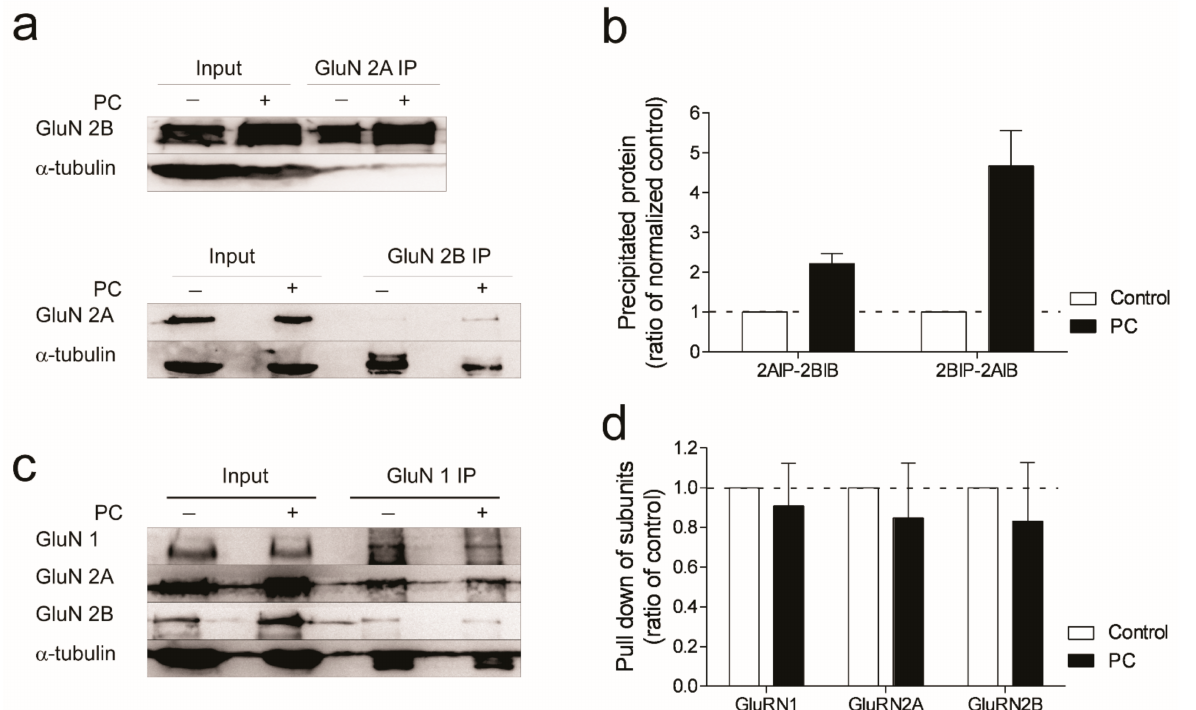
Figure 4. Increase of tri-heteromeric NMDA receptors following ischemic preconditioning. Cultured neurons of 12–13 DIV were treated with either sham OGD or 30 min OGD followed by 1 h recovery in the normoxic incubator before they were used for immunoprecipitation assay. ( a ) Immunoblots of cell lysates subjected to immunoprecipitation with GluN2A or GluN2B antibody. ( b ) Quantifi- cation of data from 3 IP assays. Data were normalized to input and expressed as a ratio of control IPs (mean ± sem). ( c ) Immunoblots of cells lysates subjected to immunoprecipitation with GluN1 antibody and blotted with antibodies specific to GluN2A and 2B. Similar levels of GluN2A and 2B are found in the control and PC neurons. ( d ) Quantified data from 3 independent assays show that no significant change is found between the control and PC neurons in regard to either GluN2A or